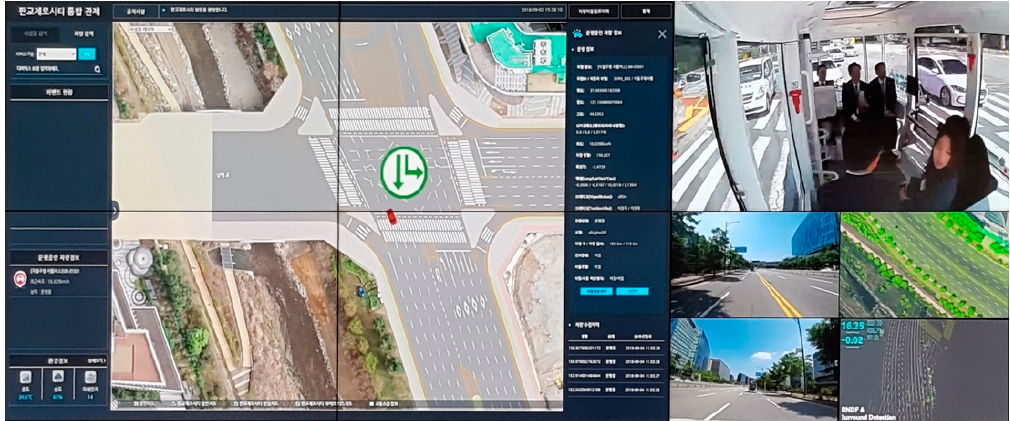
Figure 8. Operation of monitoring system of an autonomous vehicle.